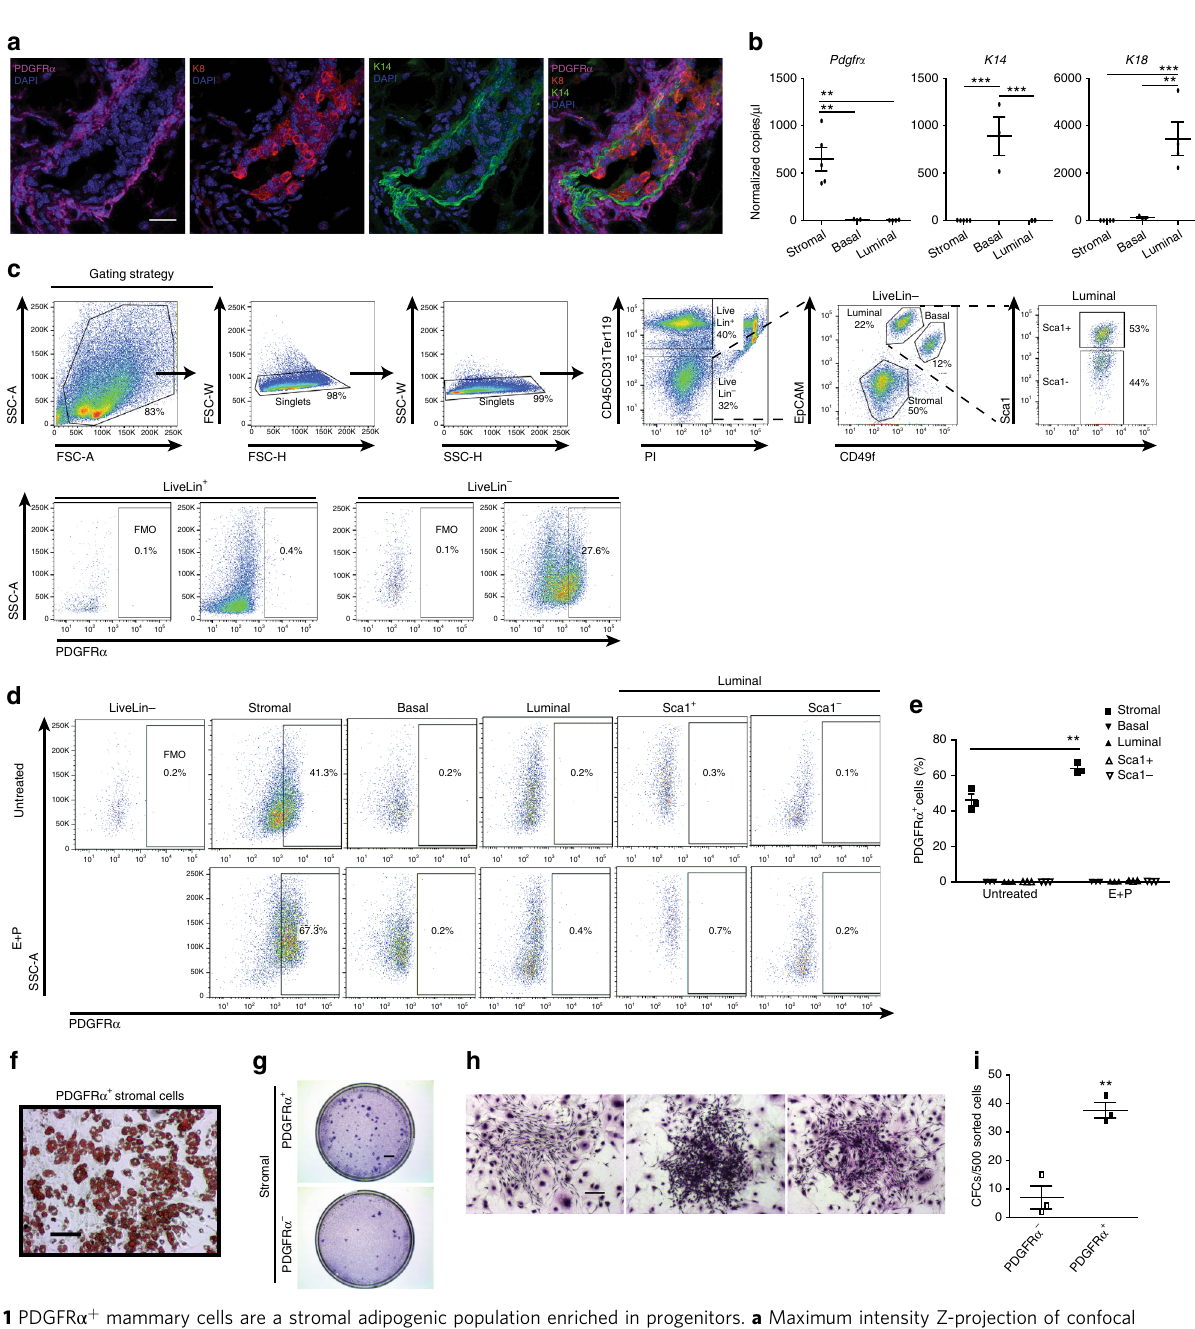
Fig. 1 PDGFR α + mammary cells are a stromal adipogenic population enriched in progenitors. a Maximum intensity Z-projection of confocal immuno fl uorescence for luminal (K8; red) and basal (K14; green) epithelial-speci fi c keratins with PDGFR α (magenta) and nuclear DAPI (blue) on a representative adult mouse mammary tissue section ( n = 3 mice, 5 fi elds per section); scale bar = 25 µ m. b Droplet digital PCR analysis of Pdgfr α and epithelial keratins K14 , K18 normalized to Gapdh in fl uorescence-activated cell sorting (FACS)-sorted stromal (CD49f - EpCAM - , n = 5) and luminal (CD49f lo EpCAM + , n = 4), basal (CD49f hi EpCAM + , n = 3) mammary epithelial cells. c FACS gating strategy used to exclude doublets and dead cells (PI + ) from analysis of PDGFR α + cells within the lineage + (Lin + ) population that consists of haematopoietic (CD45 + ), endothelial (CD31 + ) cells and erythrocytes (Ter119 + ), and the Lin - population that consists of mammary stromal and epithelial subpopulations segregated using indicated cell surface markers; fl uorescence minus one (FMO) control. d Flow cytometry analyses of PDGFR α + cells within distinct mammary subpopulations derived from adult mammary glands of untreated or sex hormone (E + P) treated mice ( n = 3 mice per group). e Quanti fi cation of PDGFR α + cells in (d). f Image of adipocyte differentiation and lipid accumulation in FACS-sorted PDGFR α + cells as detected by Oil Red O staining (representative of cultured sorted cells from n = 6 individual mice); scale bar = 100 µ m. g Colony forming cell (CFC) assay performed on sorted PDGFR α - and PDGFR α + stromal cells ( n = 6 mice); scale bar = 5 mm. h Representative stromal colonies generated by PDGFR α + cells ( n = 6 mice); scale bar = 200 µ m. i CFC capacity of PDGFR α - and PDGFR α + cells ( n = 3 mice). Data represent mean ± s.e.m. *p< 0.05, **p<0.01, ***p<0.001 ( t -test). Source data are provided as a Source Data fi